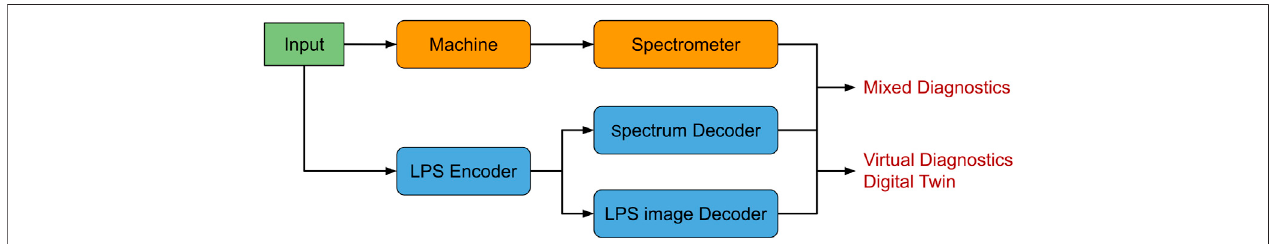
FIGURE 1 | Applications of an encoder-decoder neural network model with more than one decoder for heterogeneous predictions of electron bunch longitudinal